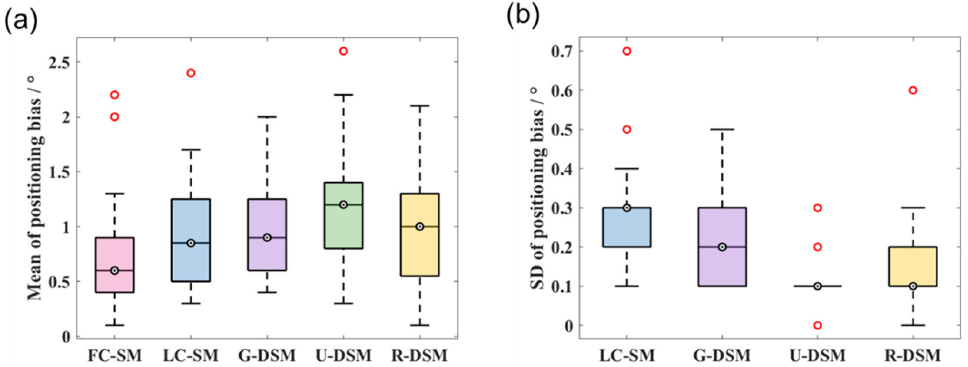
Figure 20. Box plots of ( a ) mean values and ( b ) SD values of positioning bias at 36 different source positions for 99m Tc source in inter-device evaluation.